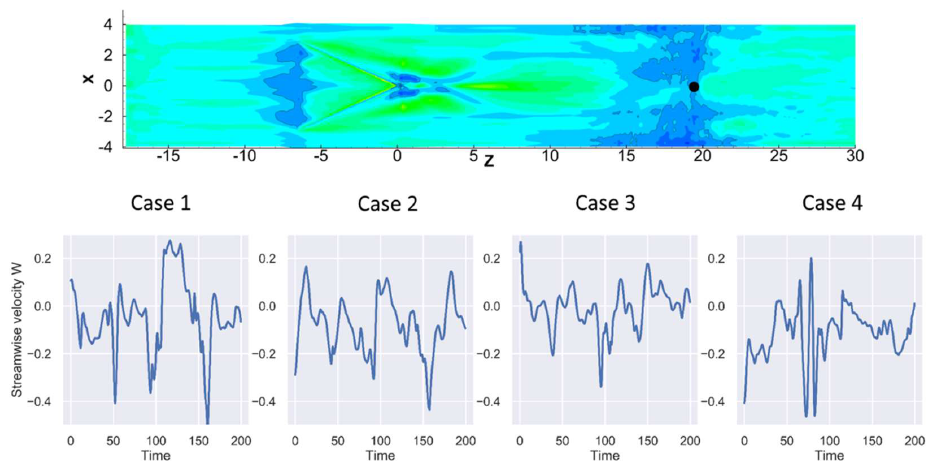
Figure 13. The signals of streamwise velocity 𝑤 at the wall of ramp corner center (position indicated